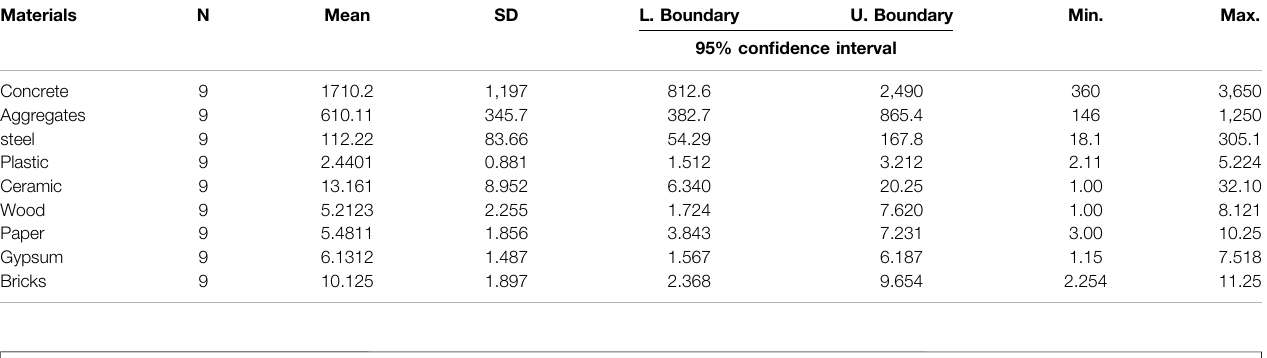
TABLE 3 | Descriptive outcome of questionnaire.